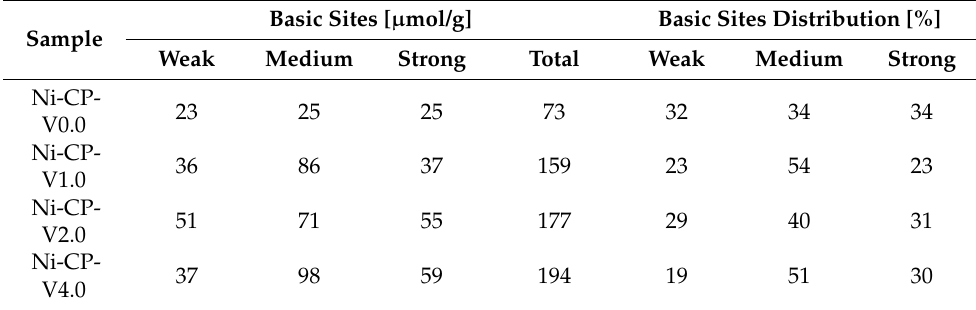
Table 4. Basicity (from CO 2 -TPD) of reduced